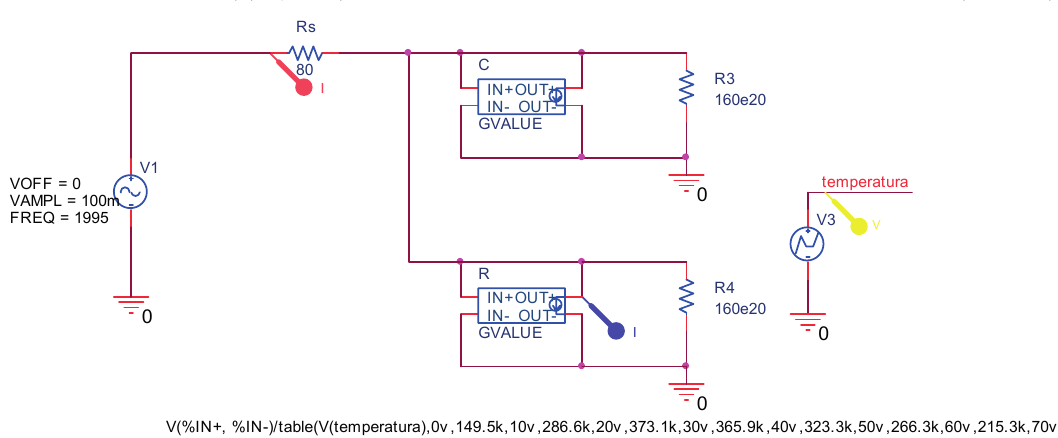
Figure 8. Orcad schematics of the complex equivalent electric circuit of the homeotropic MLC-6290